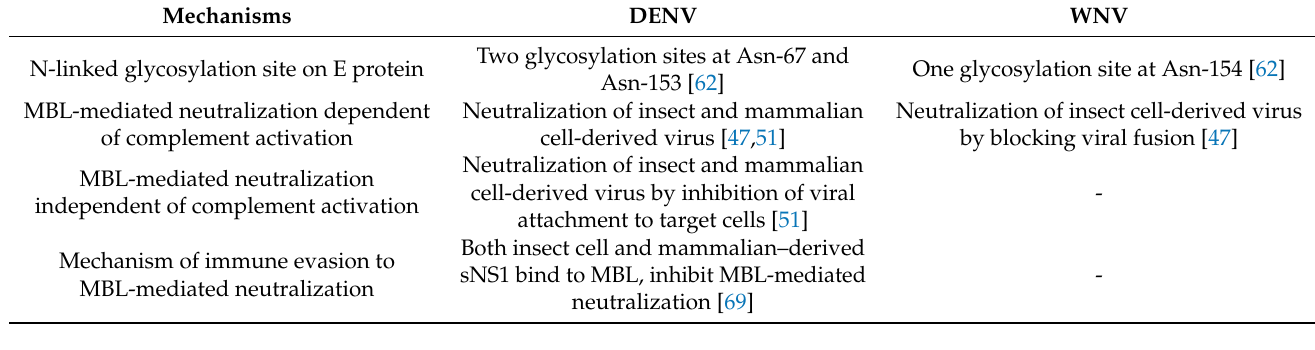
Table 1. Comparison of MBL-mediated neutralization between DENV and WNV.